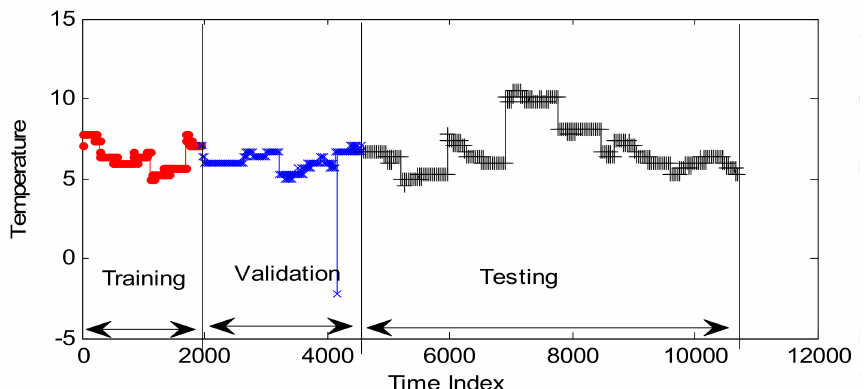
Figure 14. The training set, validation set, and testing set.